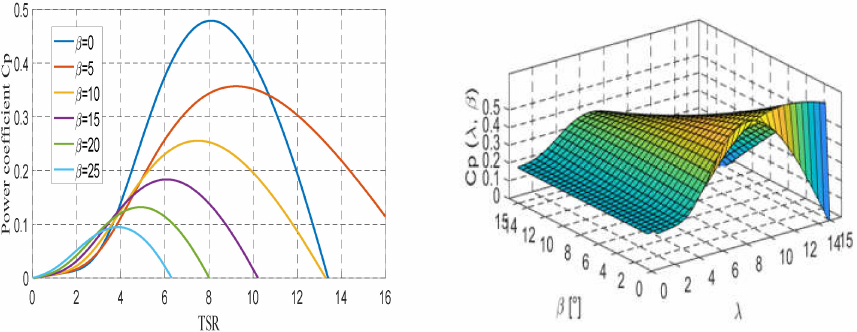
Figure 2. Power coefficient as a function of λ and β